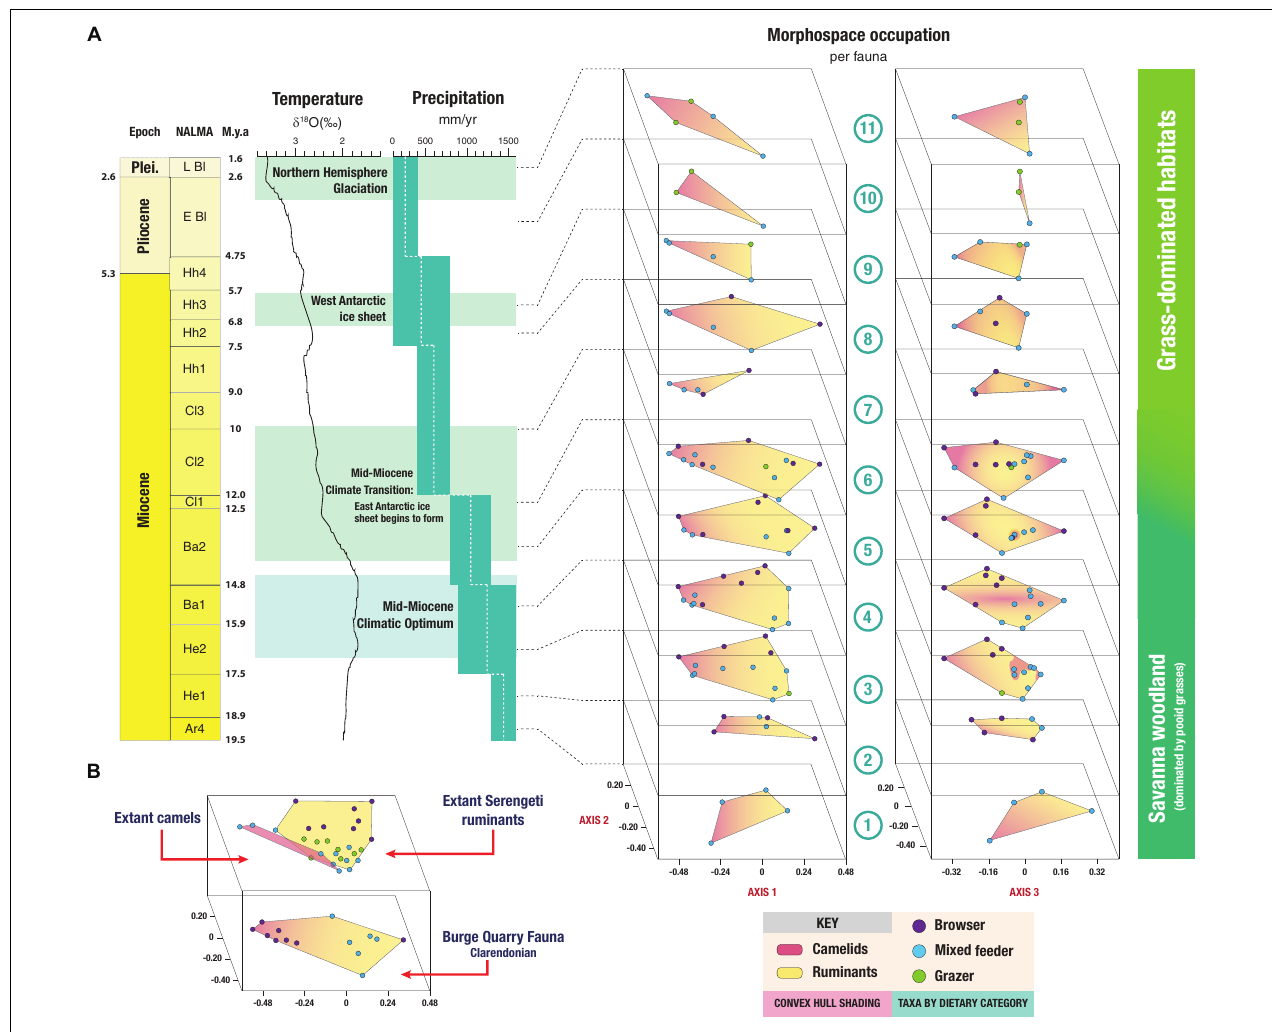
FIGURE 6 | (A) Changes in morphospace occupation throughout the Neogene of ruminant and camelid artiodactyl faunas from the Central Great Plains of North America in comparison to the then prevailing environmental conditions. δ 18 O values used as a proxy for mean annual global temperature (from Zachos et al., 2001). Precipitation values from the Great Plains are displayed in mm/year (from Eronen et al., 2012). Convex hulls show morphospace occupation of ungulate faunas: pink areas denote camel morphospace and yellow areas ruminant morphospace. Locality numbers as in Figure 2 . Axes of morphospace plots as in Figure 4A (on the left) and Figure 4B (on the right). (B) Comparison between the morphospace occupation (axes one and two) of the most diverse Neogene North American fauna (Burge Quarry [Clarendonian]), the extant ruminant Serengeti fauna, and the extant camelids. Proposed dietary categories of extinct taxa obtained from the results of the phylogenetic flexible discriminant analysis (shown in Figure 5